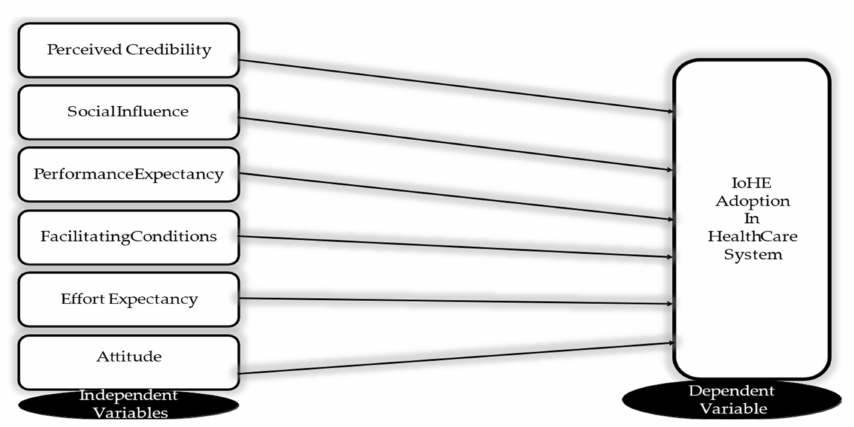
Figure 3. Conceptual framework for the adoption of IoHE in healthcare.